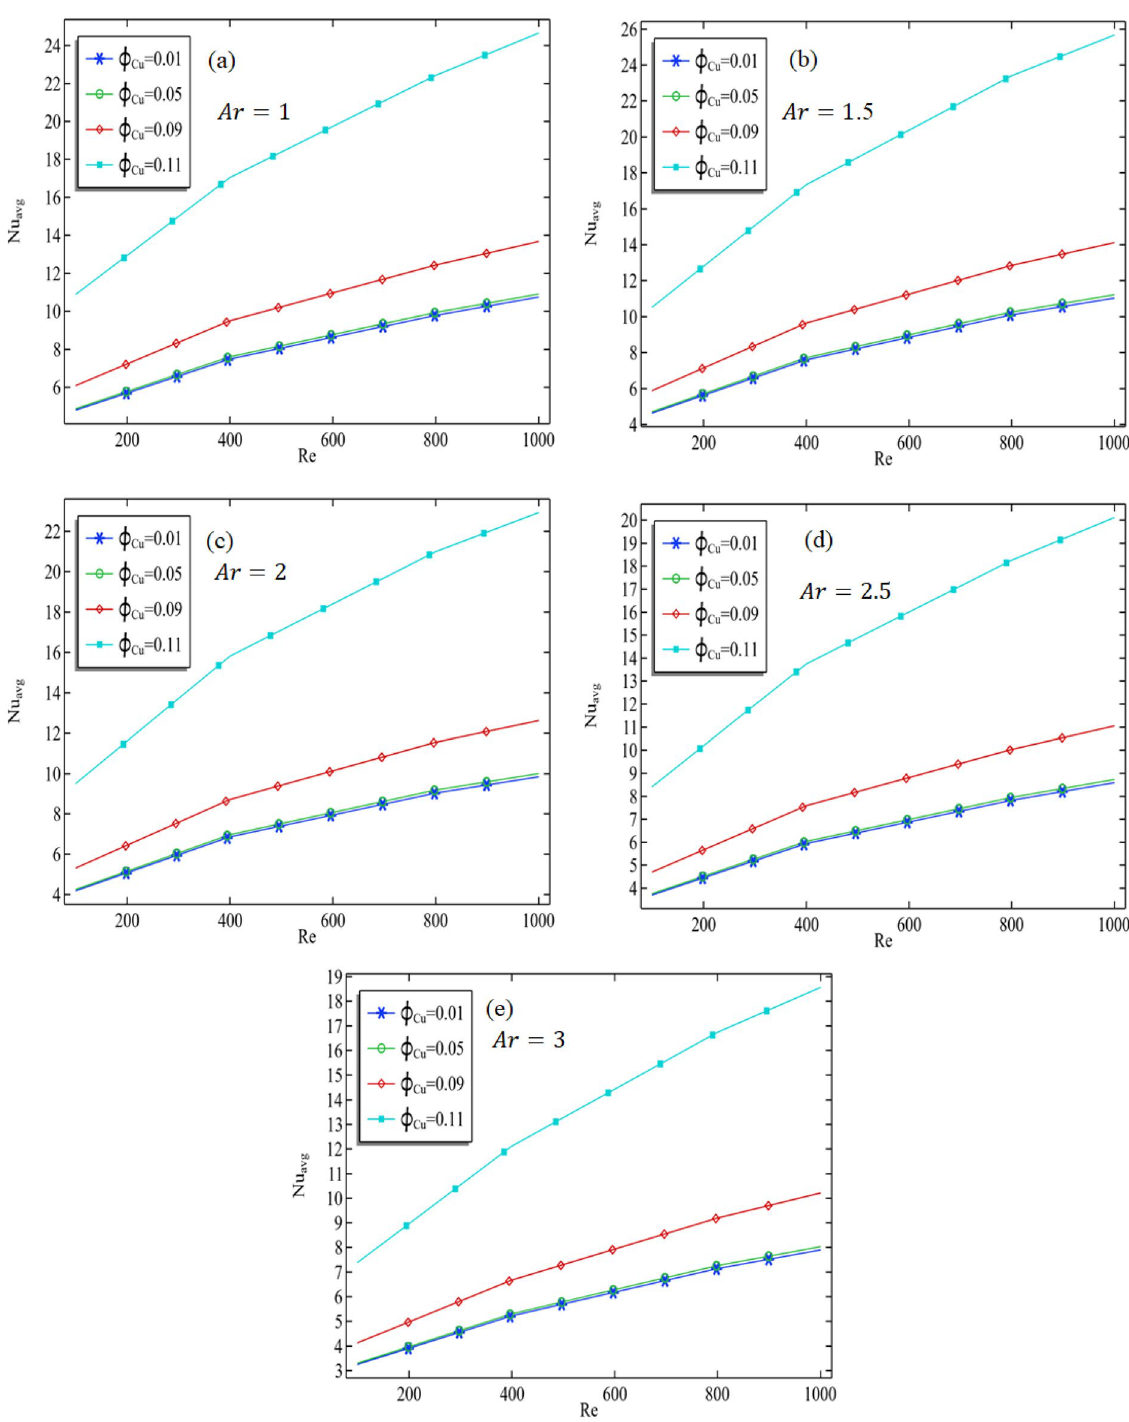
Figure 8. The average Nusselt number at the middle of the cavity against increasing Reynolds number with different aspect ratios and volume